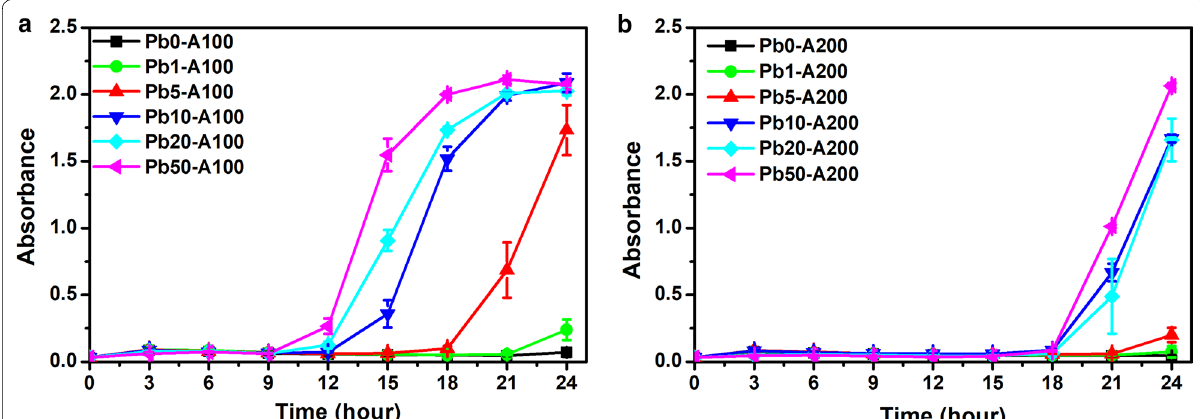
Fig. 2 Growth curves of the chassis cells with the selection plasmid in response to lead and ampicillin. The optical density at 600 nm of the E. coli (pZE21-PBS) strain was measured with lead at different concentrations of 0 µM (squares), 1 µM (circles), 5 µM (up triangles), 10 µM (down triangles), 20 µM (diamonds), and 50 µM (left triangles). Ampicillin was used at a 100 µg mL − 1 and b 200 µg mL − 1 . Experiments were performed in triplicate, and data represent the averages and standard deviations of the